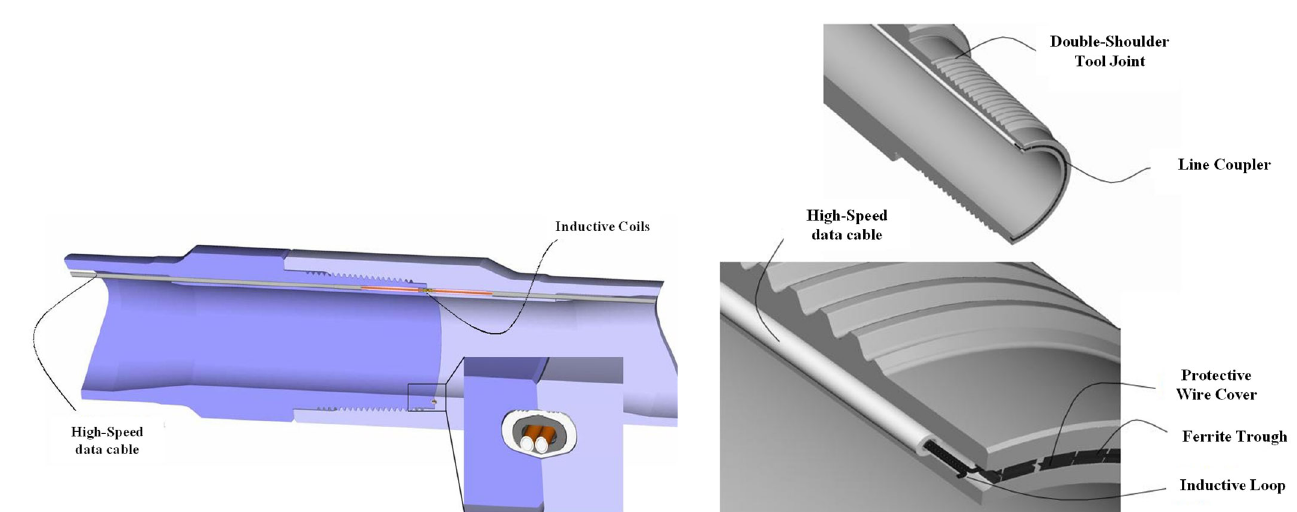
Figure 4. Principle and structure diagram of the induction transmission technology.